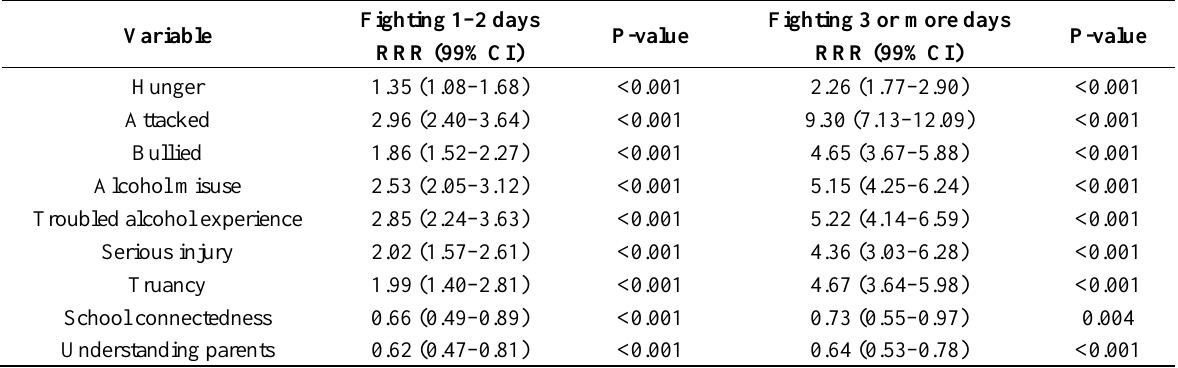
Table 3. Multinomial regression analyses of selected variables examined